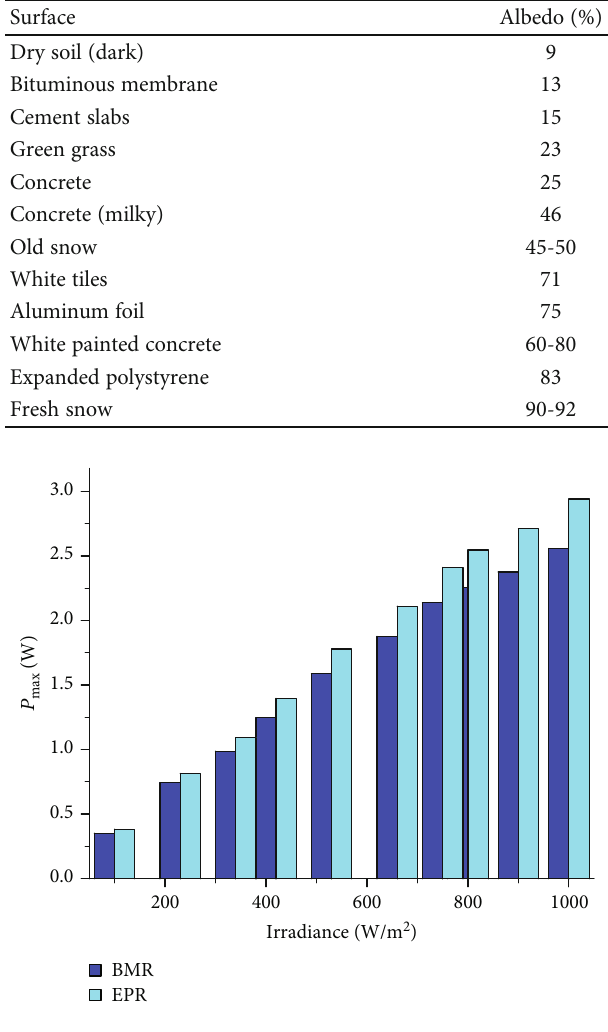
Table 3: Albedo values.